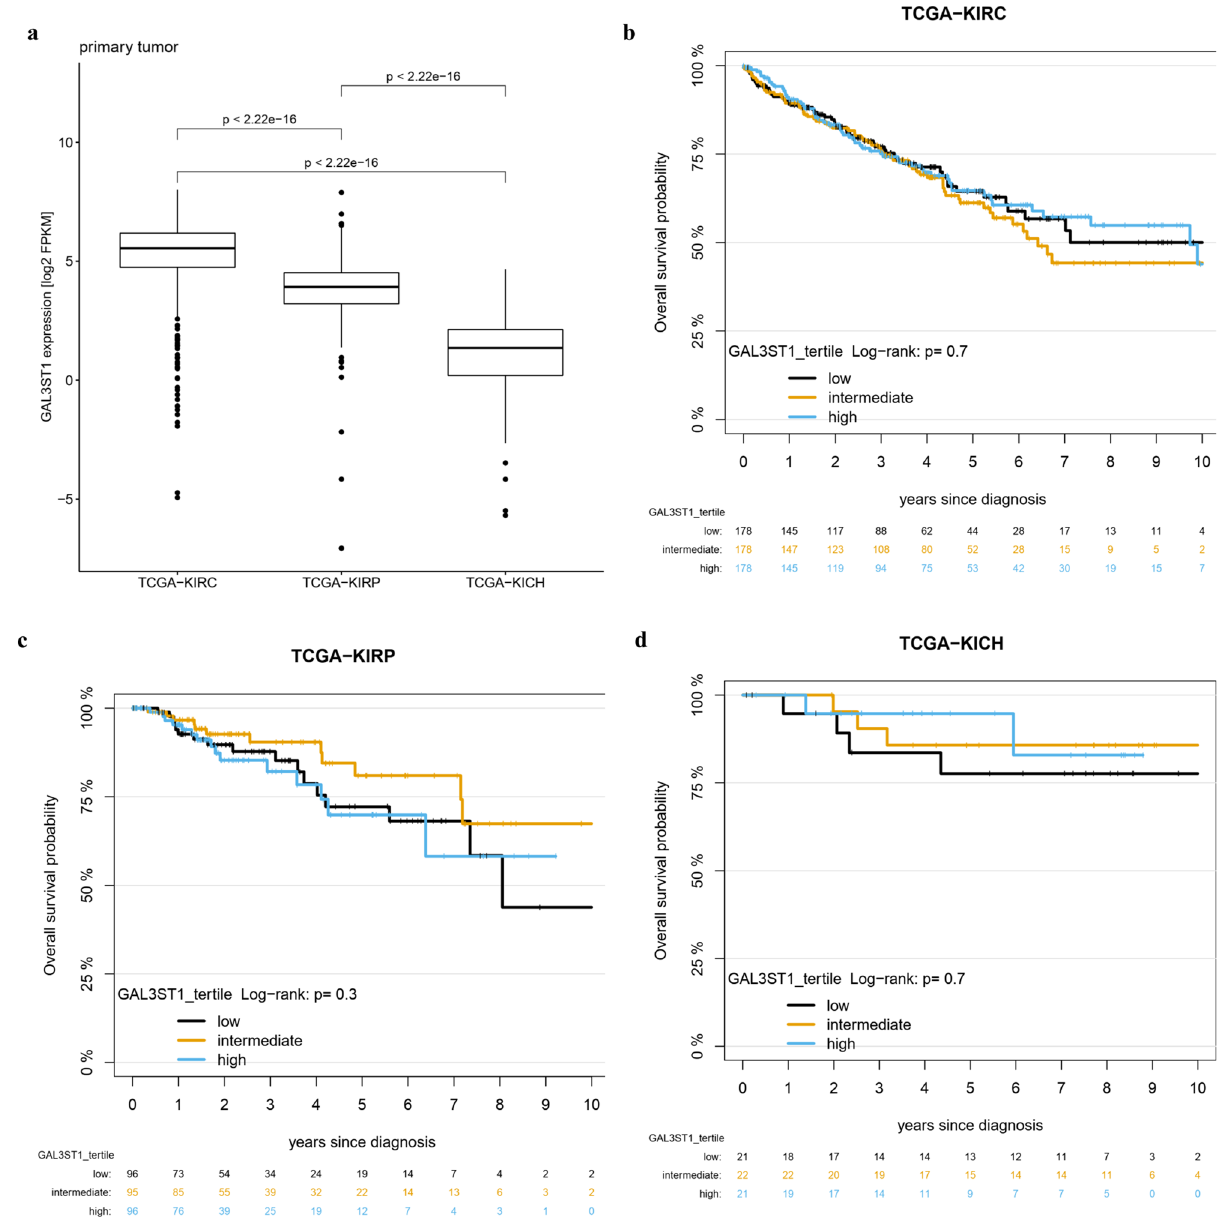
Figure 3. ( a ) Analysis of Gal3ST1 mRNA expression in TCGA cohort of ccRCC (‘KIRC’), pRCC (‘KIRP’) and chRCC (‘KICH’) patients. ( b ) Kaplan–Meier curves for overall survival probability for three histotypes from TCGA using tertile cut-offs for Gal3ST1 mRNA